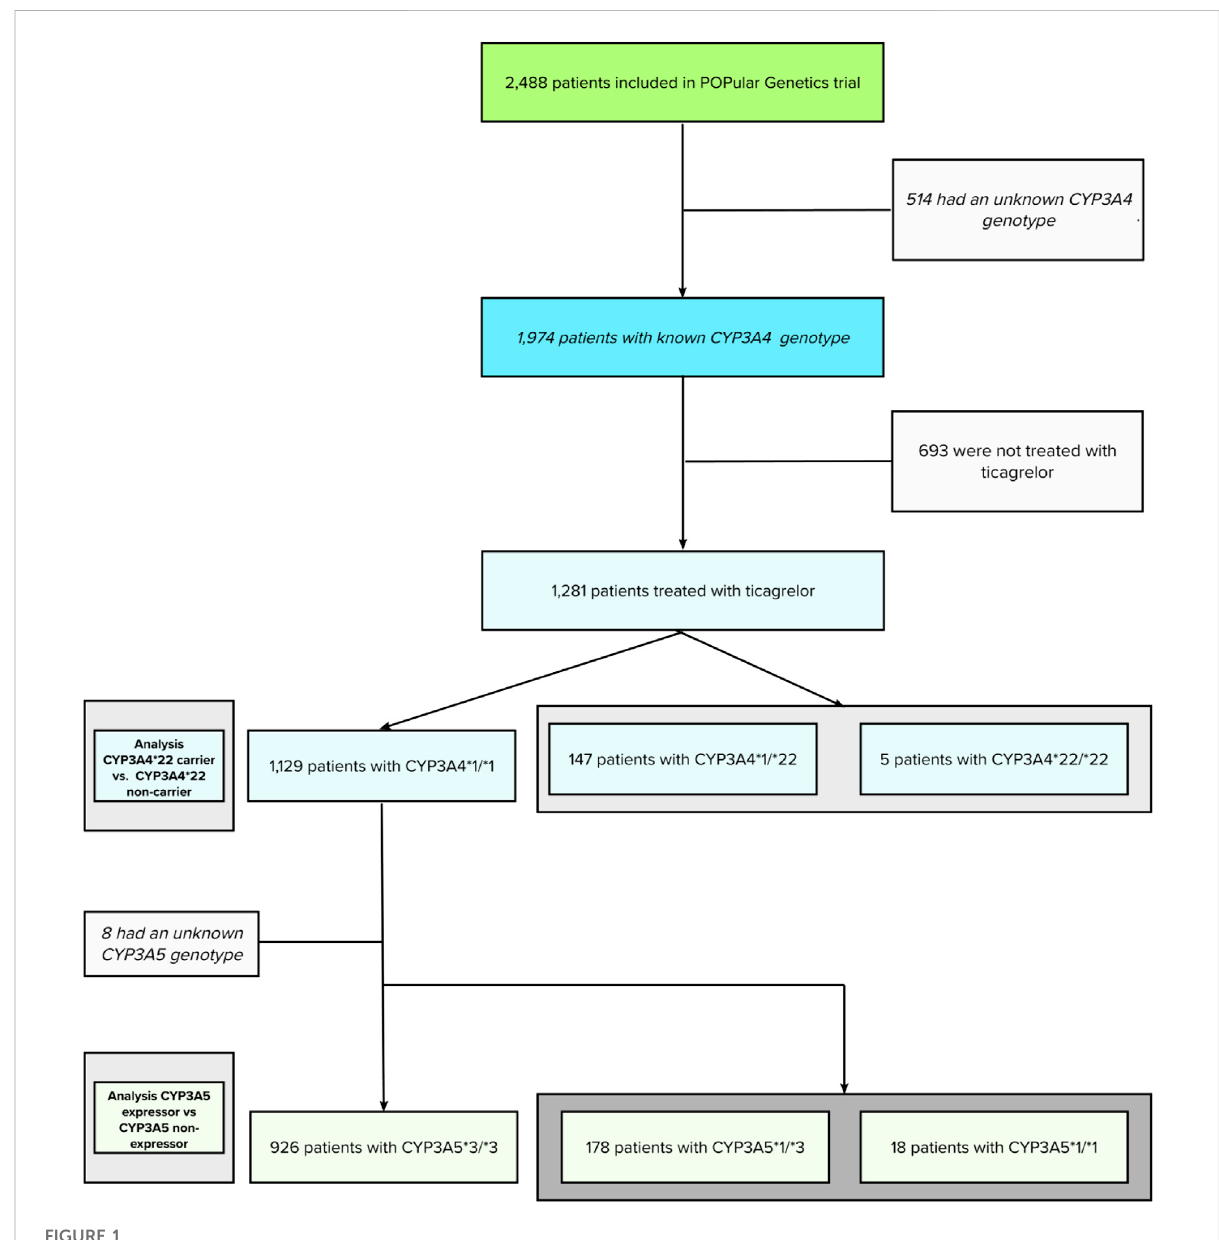
FIGURE 1 Flowchart of the POPular Genetics CYP3A4 and CYP3A5 sub